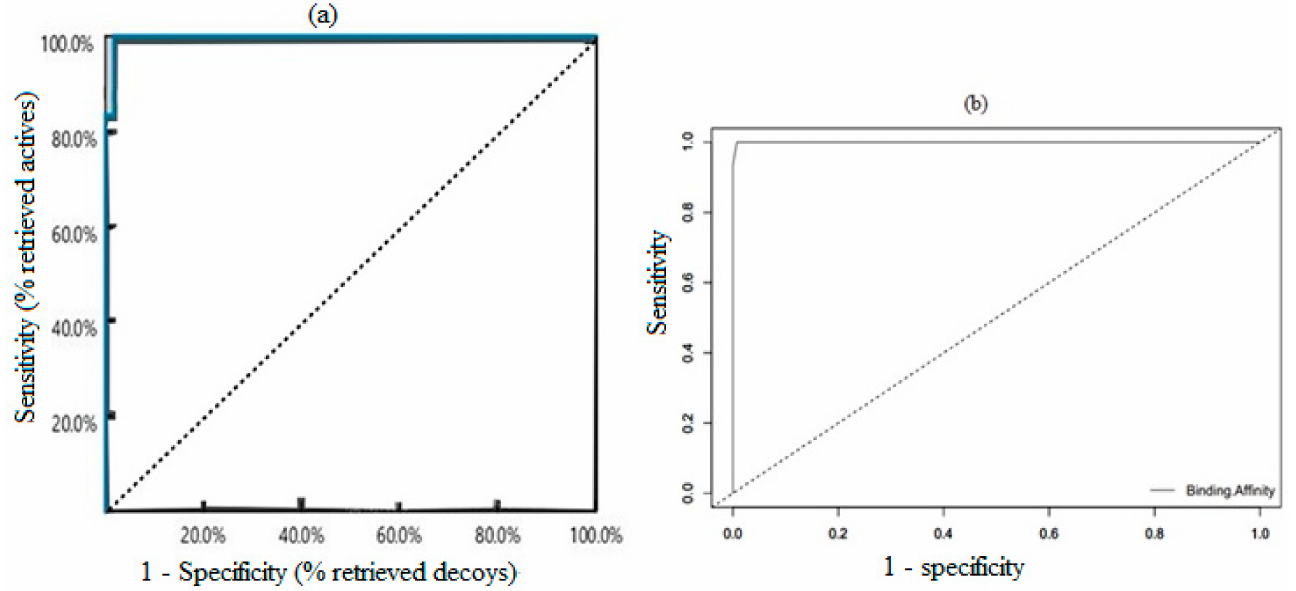
Figure 4. ROC curves for validation of the pharmacophore model and the docking protocols. ( a ) ROC curve of the selected pharmacophore model showing both the AUCs and EFs as mea- sured in the top 1%, 5%, 10%, and 100% to be 52.0, 26.0, 26.0, and 26.0, respectively. ( b ) ROC curve generated after docking six active compounds and 300 decoys. The further away the median (that is, the dotted line) is from the curve, the better the